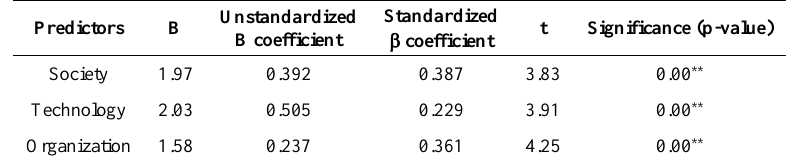
Table 12. Regression results in the impact of digital transformation on organizational reform of the state administrative apparatus